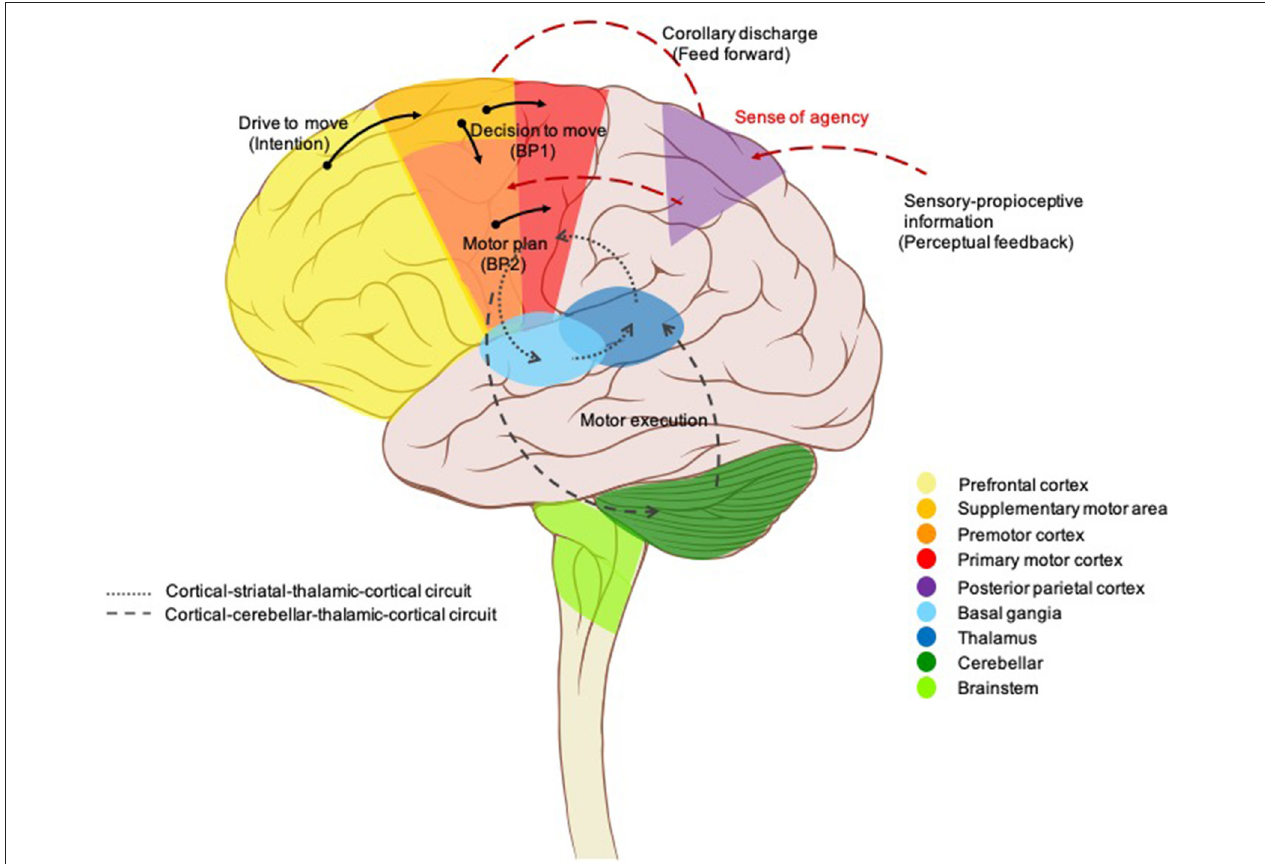
FIGURE 2 | Brain circuits control voluntary movement. Voluntary movements are executed consciously under the control of the brain, starting with the intention to move created in the prefrontal cortex and limbic area. Next, presupplementary and supplementary motor areas are involved in programming the complex sequences of movements required. The premotor cortex primarily selects movements based on external information from the parietal cortex, it also contributes to some aspects of voluntary movement. The presupplementary and supplementary motor areas; together with the premotor area generate the readiness potentials (Bereitschaftspotential 1). This information is sent down via the motor cortex to two side loops—basal ganglia and cerebellum—for checking and modulating motor control. Then, it needs to be conveyed to the motor cortex again passing through the thalamus. A corollary discharge is also created in parallel (feedforward model) and then sent to the parietal cortex for comparison with the proprioceptive feedback, resulting in a sense of agency. Finally, the neural signal leaves the primary motor cortex (Bereitschaftspotential 2) for the spinal cord and contralateral muscles to trigger the actual